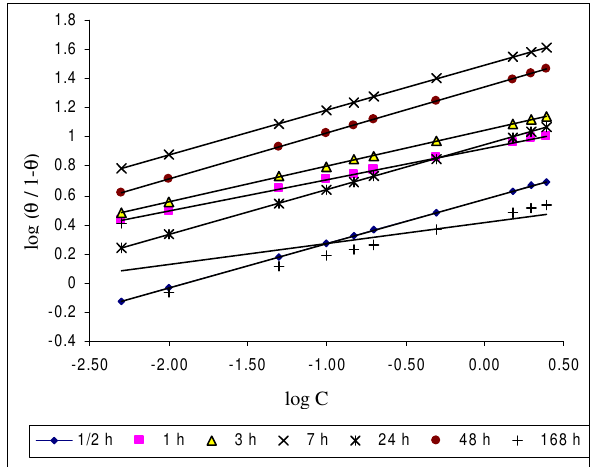
Figure 2 . Langmuir adsorption